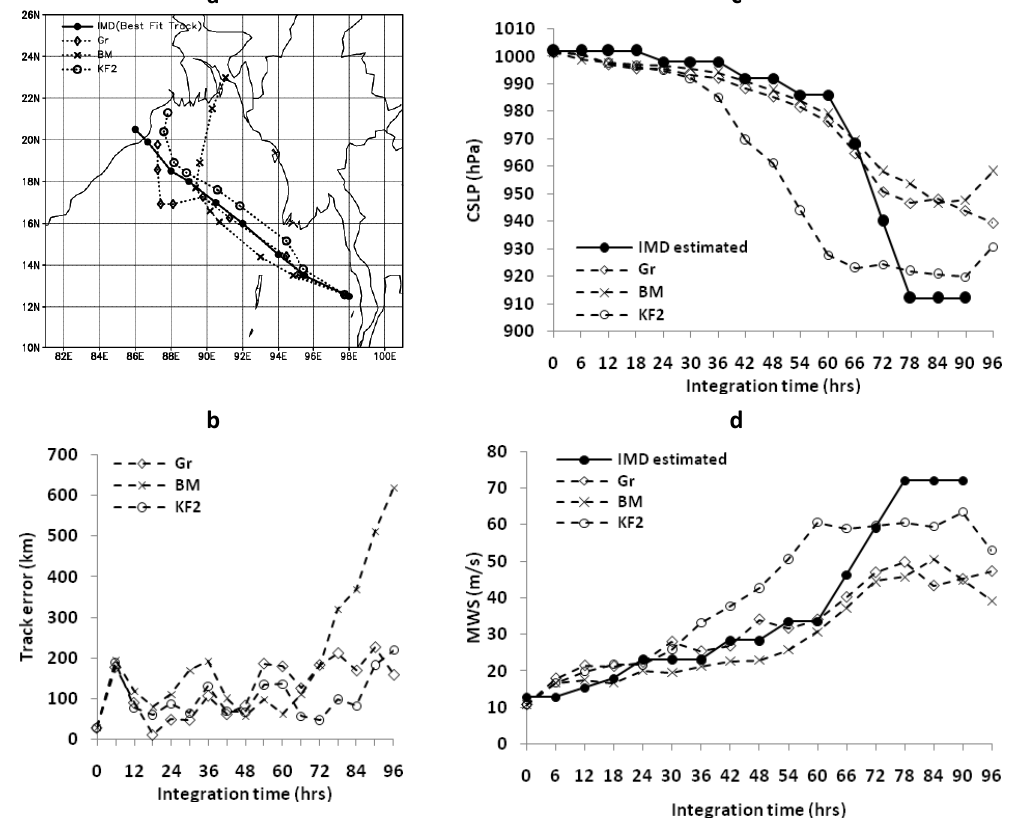
Fig. 2. (a) model simulated tracks and time series plots of (b) track error, (c) central sea level pressure (CSLP) in hPa and (d) maximum wind speed (MWS) in ms − 1 for the experiments with different CPS, namely Gr, BM and KF2 along with IMD data. The model integration is started on 12:00UTC, 25 October